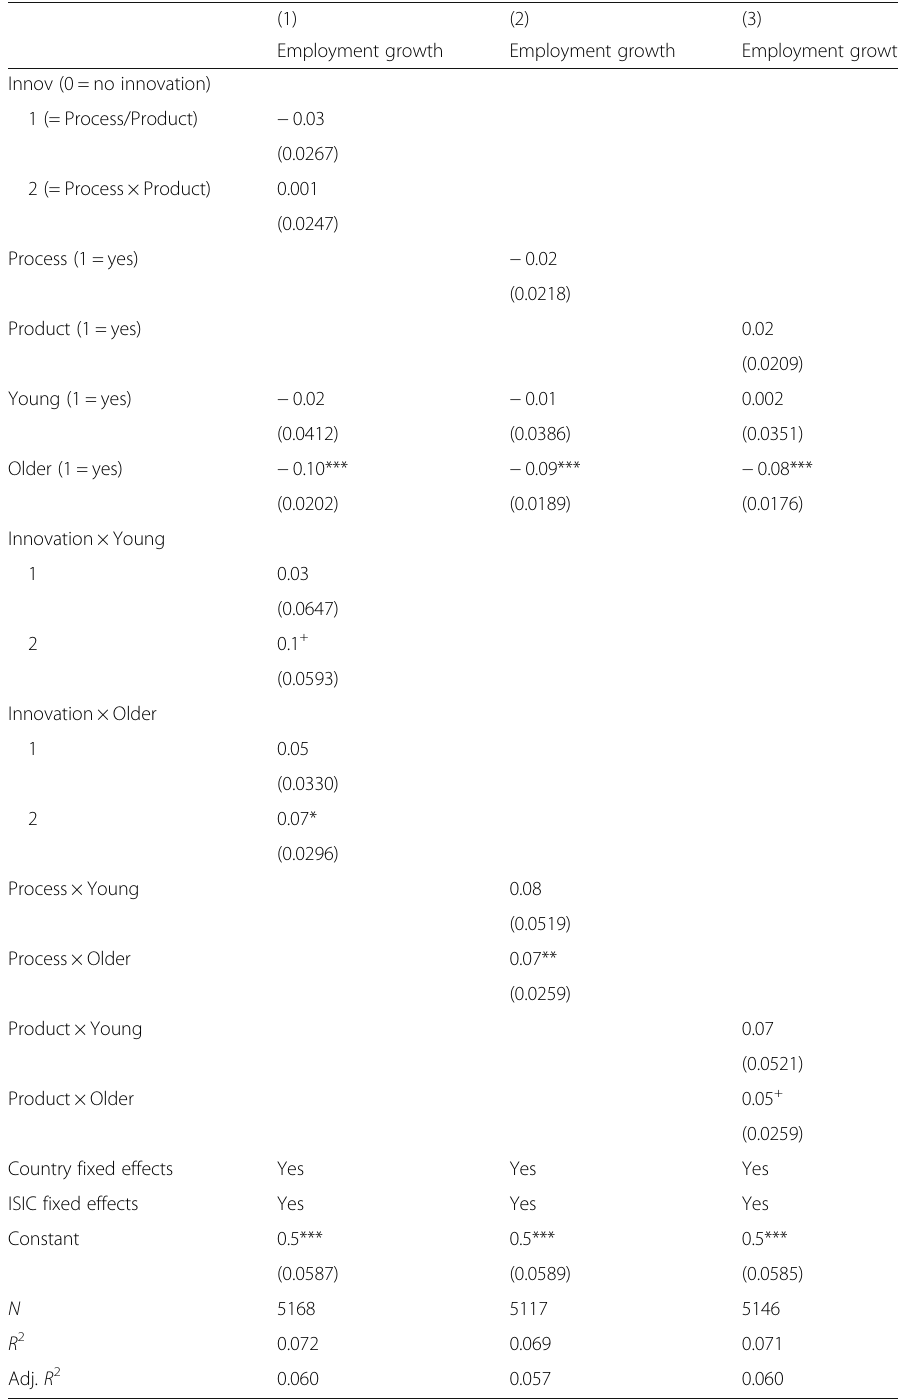
Table 5 Interaction between innovation and firm age (1) (2) (3) Employment growth Employment growth Employment